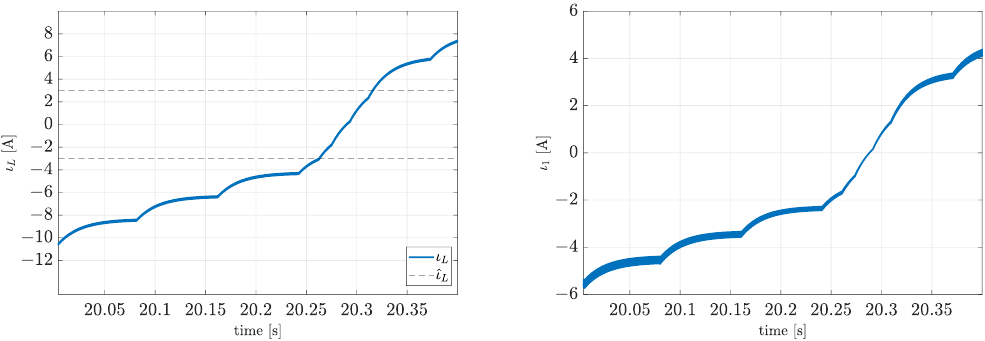
Figure 9. Buck mode. Monotonic convergence of current ι L ( blue solid line ) compared with threshold ˆ ι L ( black dashed line ), left plot; monotonic convergence of of current ι 1 ( blue solid line ), right